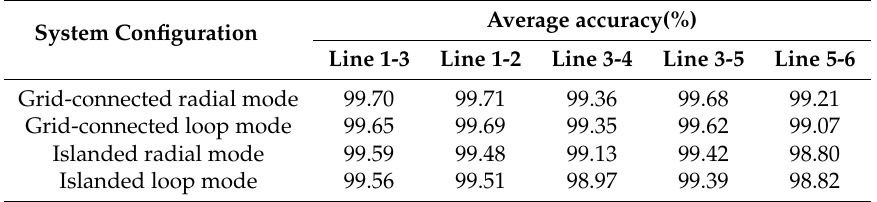
Table 2. Average accuracy for different system